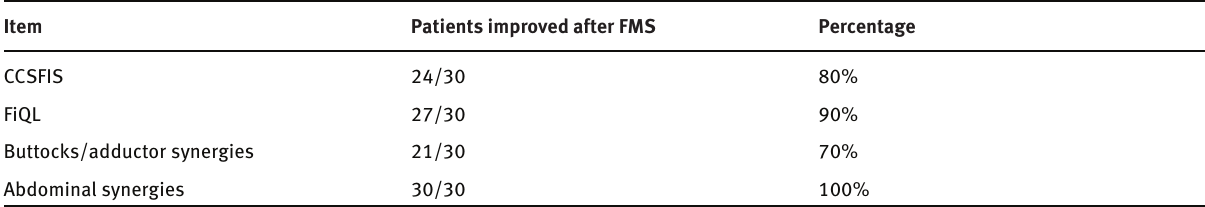
Table 3: FI clinical items improvements. Values expressed as number of cases and percentage. FI (fecal Incontinence) FMS (functional extra- corporeal magnetic stimulation); CCSFIS (Cleveland Clinic Faecal Incontinence Score); FiQL (Fecal Incontinence Quality of Life